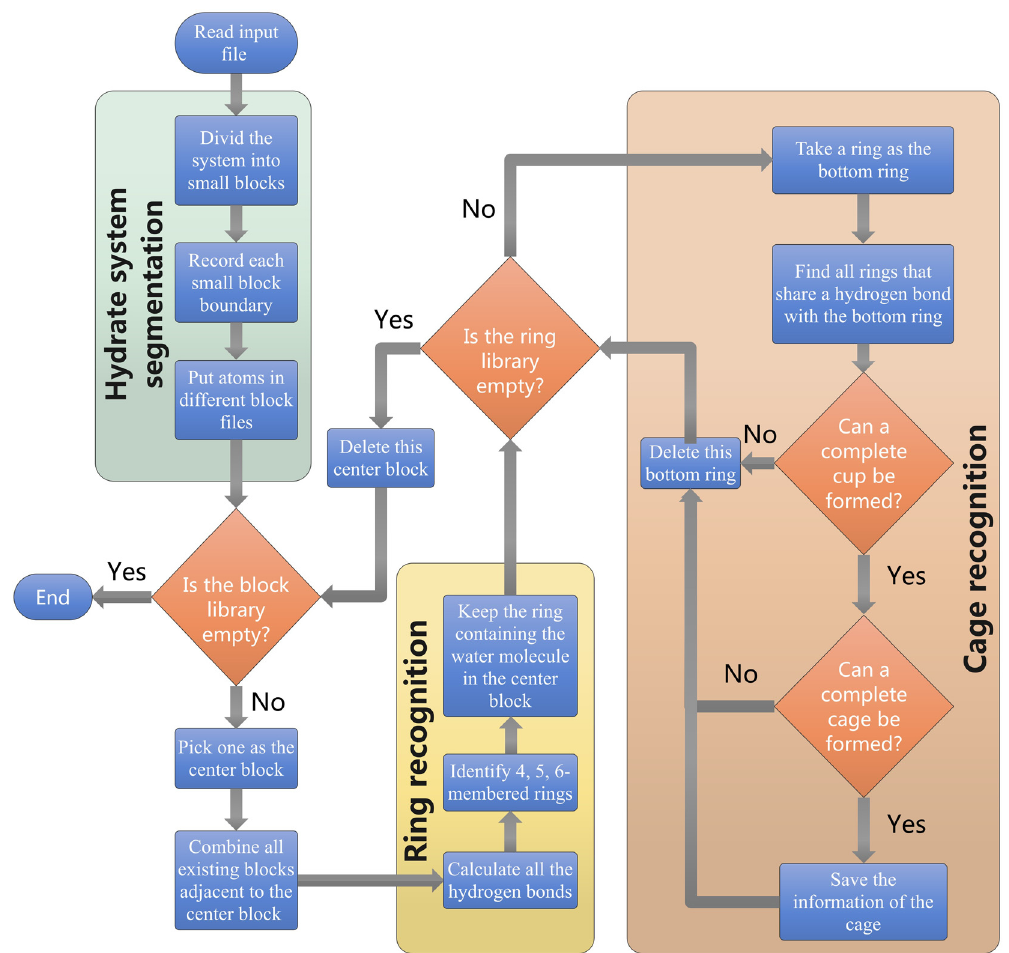
Figure 1: General fl ow chart of HTR. The algorithm is mainly divided into three processes: ( i ) hydrate system segmentation, ( ii ) ring recognition, and ( iii ) cage